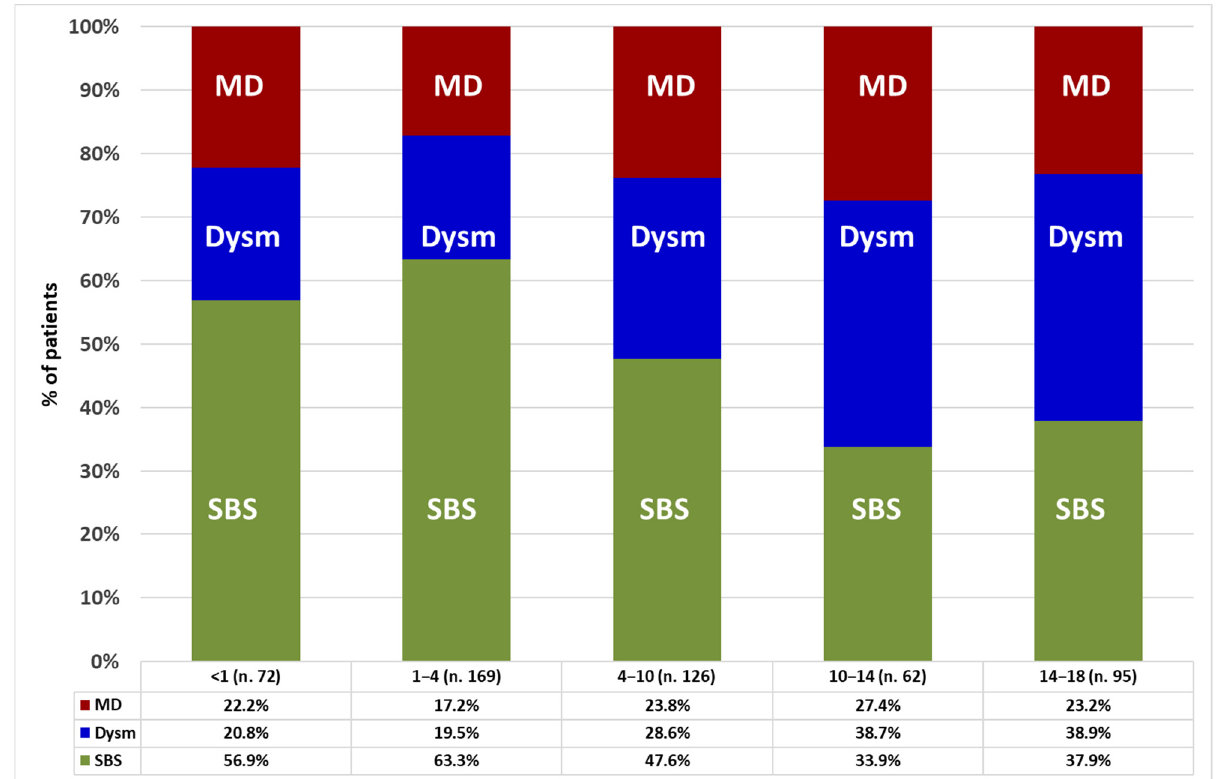
Figure 2. Prevalence of intestinal failure mechanisms in the patients’ age categories (years). Statistic: Pearson chi-square test for the whole group ( p = 0.004); linear-by-linear association test for SBS ( p < 0.001), dysmotility ( p < 0.001), and mucosal disease ( p = 0.282). Abbreviations: SBS, short bowel syndrome; Dysm, dysmotility; MD, mucosal disease.